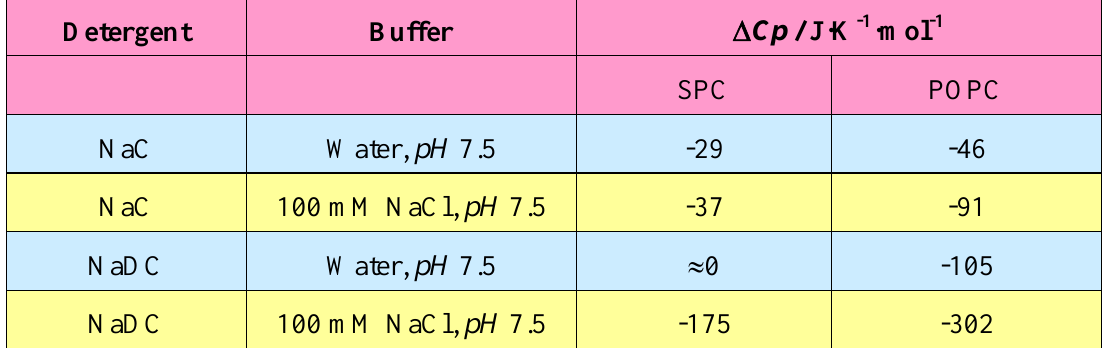
Table 5. Change of the heat capacity Δ Cp for SPC and POPC detergent systems at low and high ionic